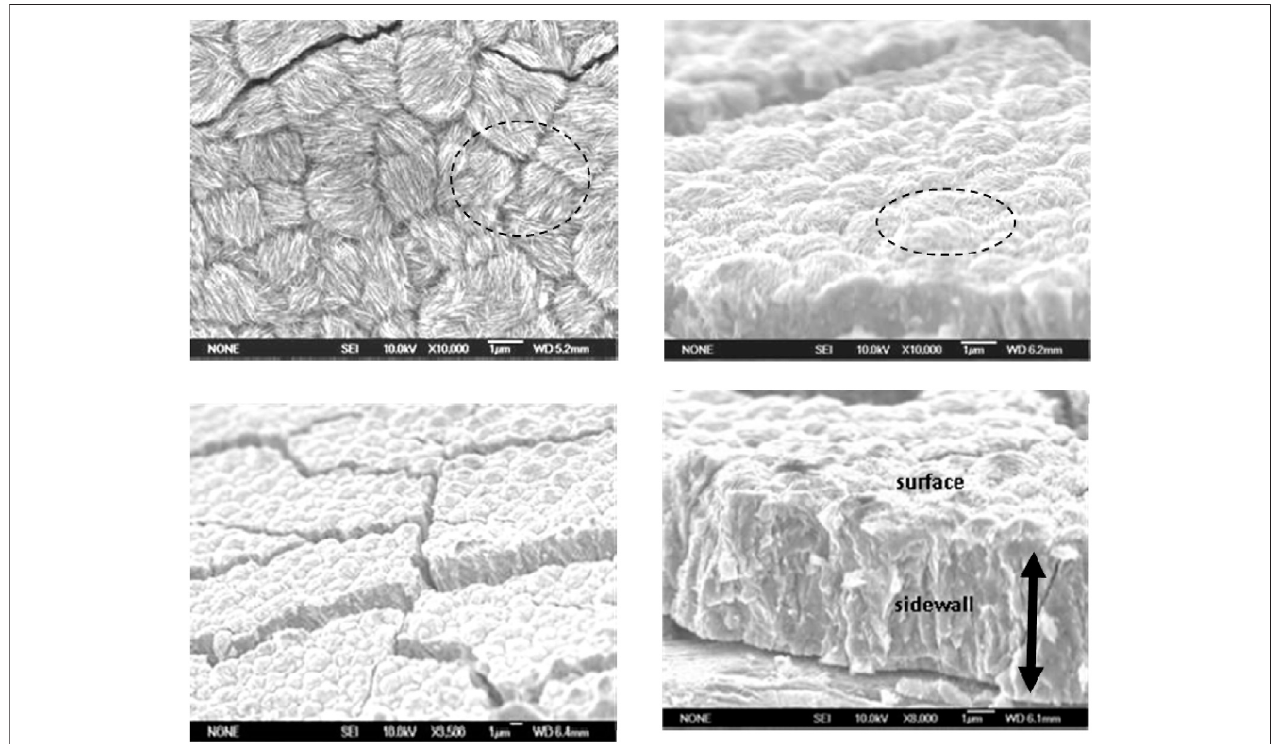
FIGURE4| Topandcross-sectionalscanningelectronmicroscopicimagesofSm-Coelectrdepositsatdifferentmagni fi cation;9.2 at%Sm, ∼ 5 μ m,pH5.7,60 ° C, 100 mA/cm 2 .